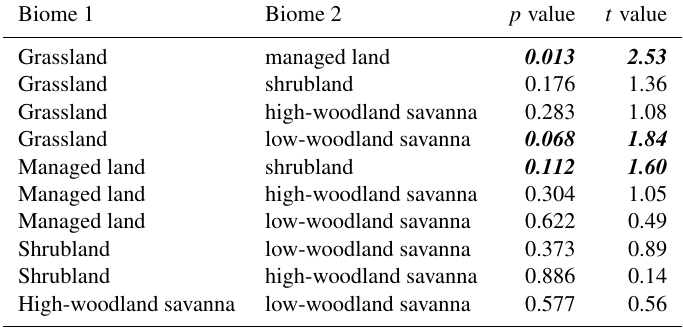
Table 2. Results detailing the statistical significance of the EC b 0.15 are bold and italicised, while any biome pair with p values above 0.15 are neither bold or